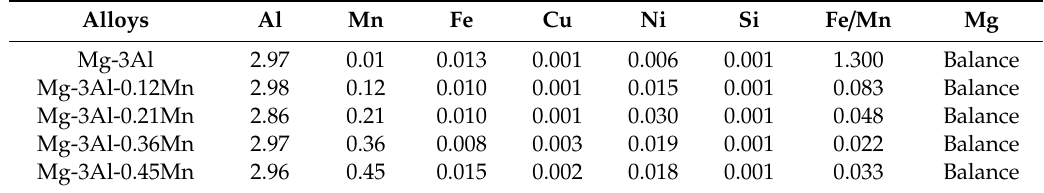
Table 1. Alloy composition (wt.%) determined by ICP-AES (inductively coupled plasma-atomic emission